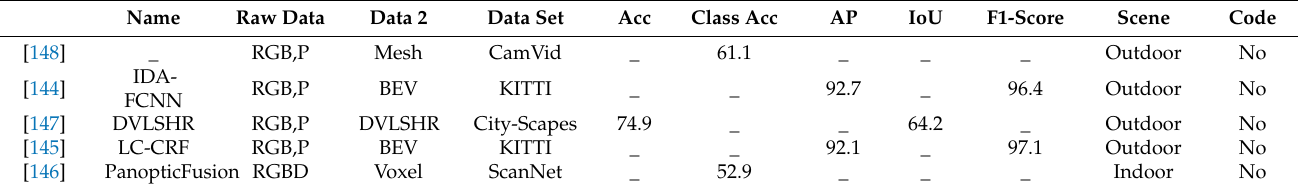
Table 7. Comparative summary of segmentation methods using result-based fusion strategy (P: point cloud; Data 2: intermediate